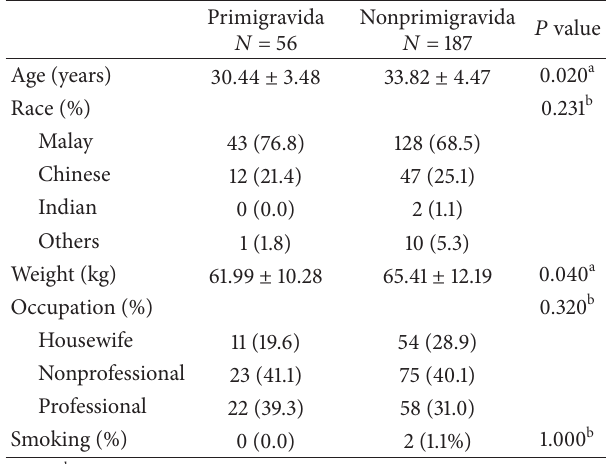
Table 1: Sociodemographic data of women with major placenta praevia.